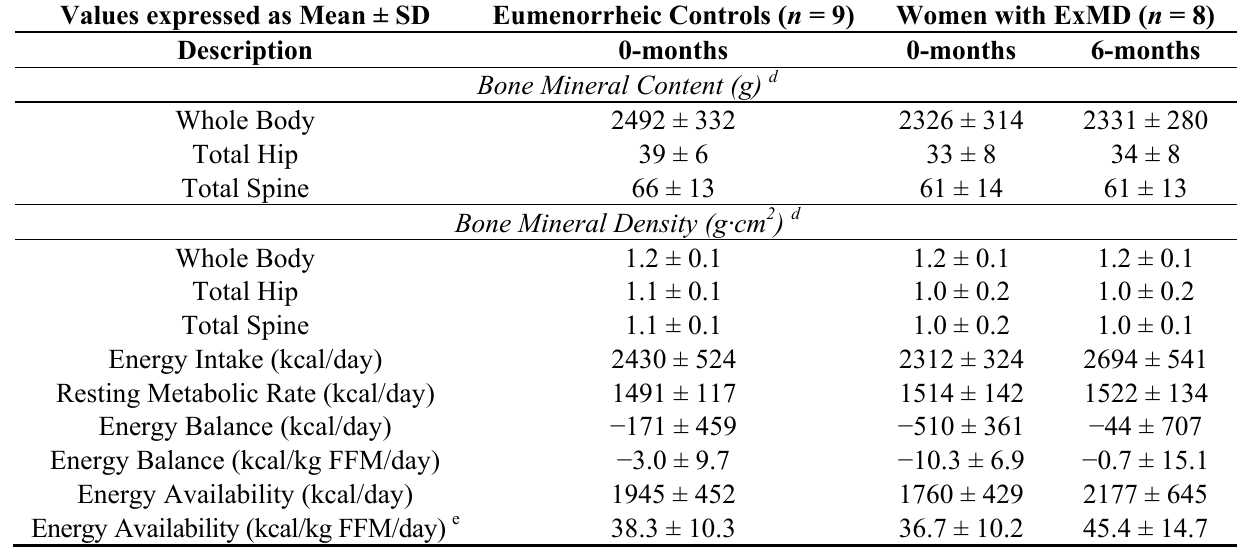
Table 2. Energy availability (EA), energy balance (EB), bone mineral content (BMC), and bone mineral density (BMD) in athletes classified as eumenorrheic (Eumen) or with exercise-induced menstrual dysfunction (ExMD) before and after a 6-month dietary intervention a–c